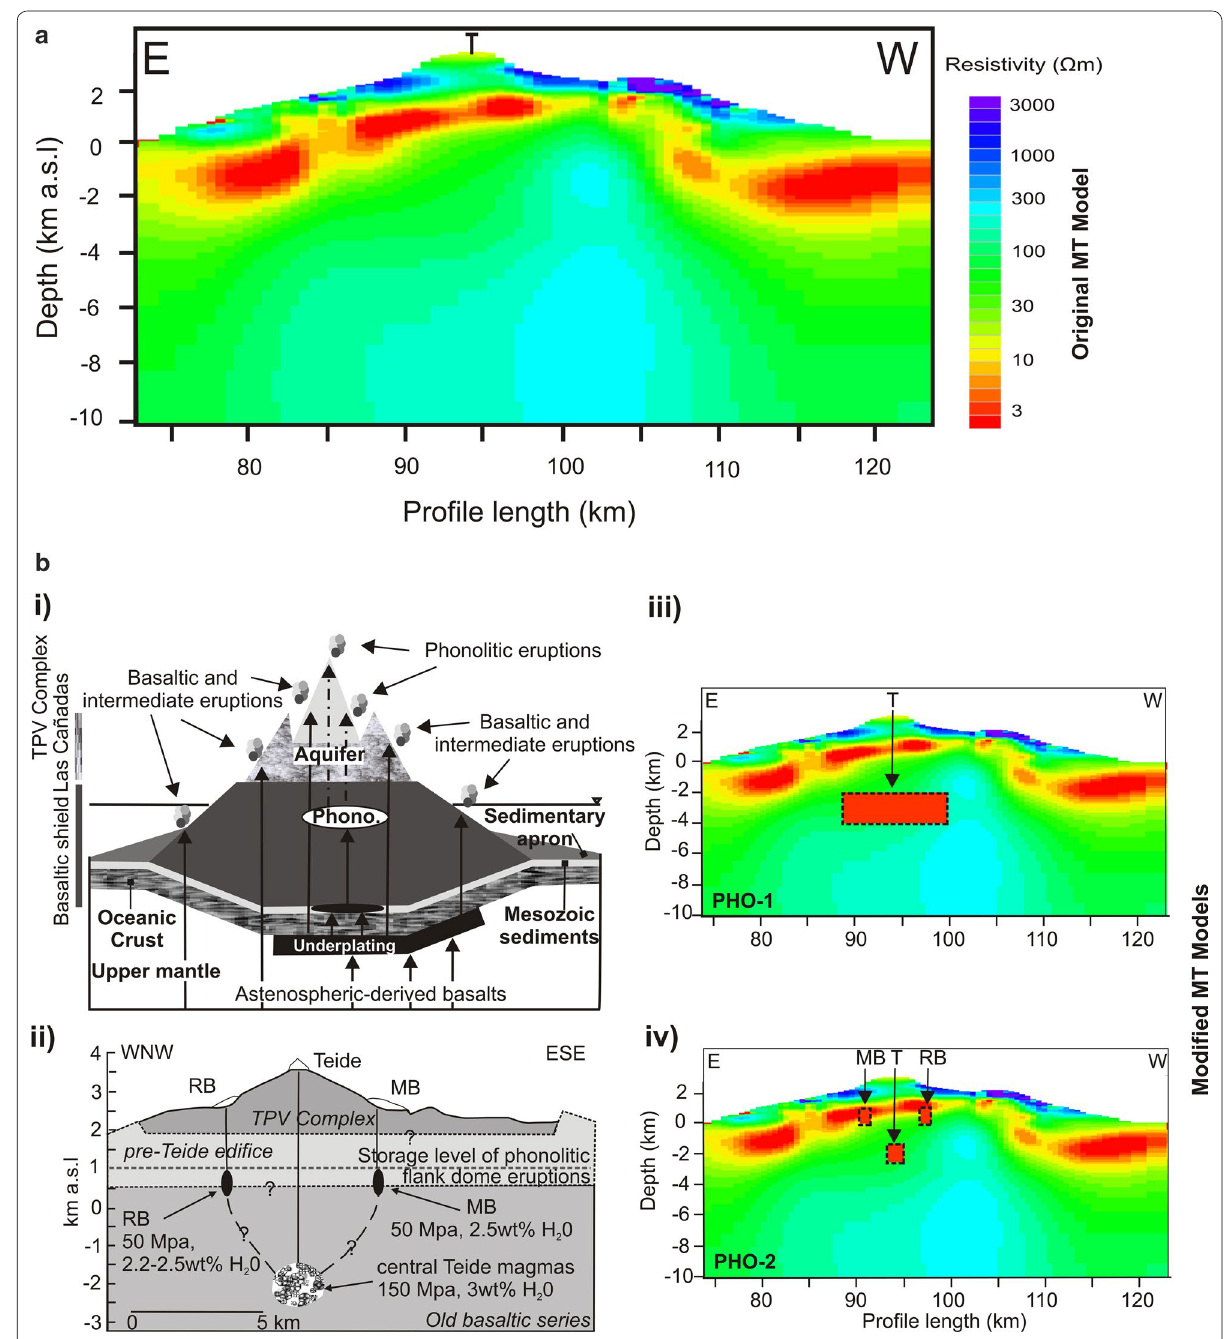
Fig. 2 Upper panel: vertical cross section of the 3‑D resistivity model ( original model ) used as a reference (Piña‑Varas et al. 2015). Lower panel: Schematic models of Tenerife magmatic system and modified resistivity models used for the phonolitic magma chambers study. a Tenerife magmatic system proposed by Martí (2008) (modified from Martí 2008); b volcanic system of Teide volcano composed of three phonolitic chambers (modified from Andújar et al. 2013); c resistivity model PHO‑1, equivalent to the volcanic system proposed by De Barros et al. (2012); d resistivity model PHO‑2, equivalent to the volcanic system proposed by Andújar et al.